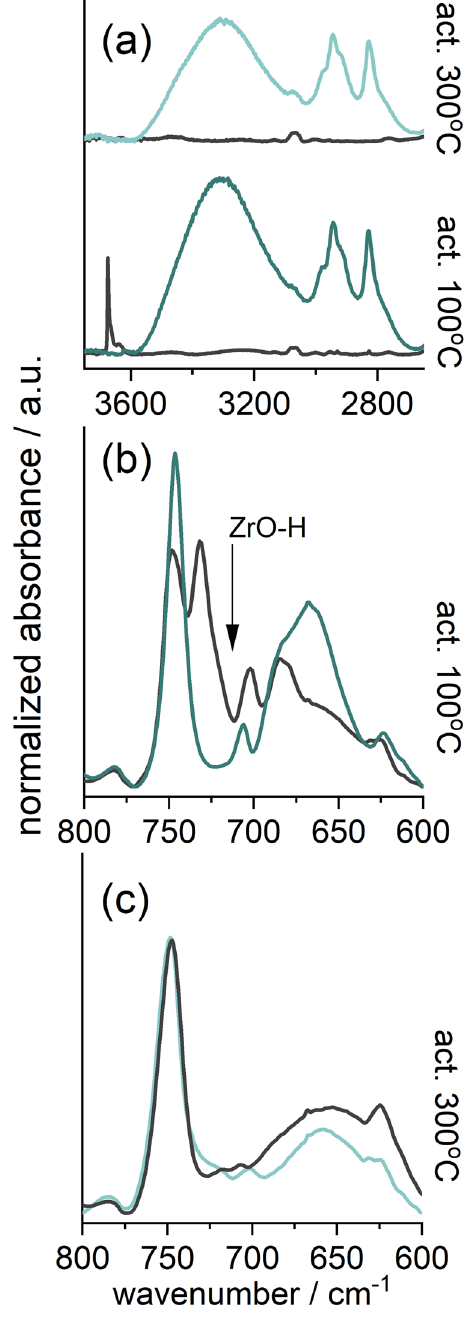
Fig. 8 IR spectra of methanol adsorbed in UiO-66_160. a The range of OH groups for sample activated at 100 °C and 300 °C; the range of skeletal vibrations for sample activated at 100 °C ( b ) and 300 °C ( c ). The gray line indicates the state before